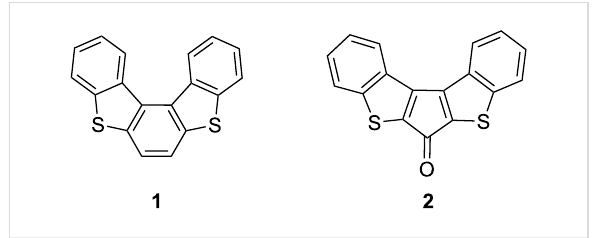
Figure 1: Chemical structures of 1 and 2 .